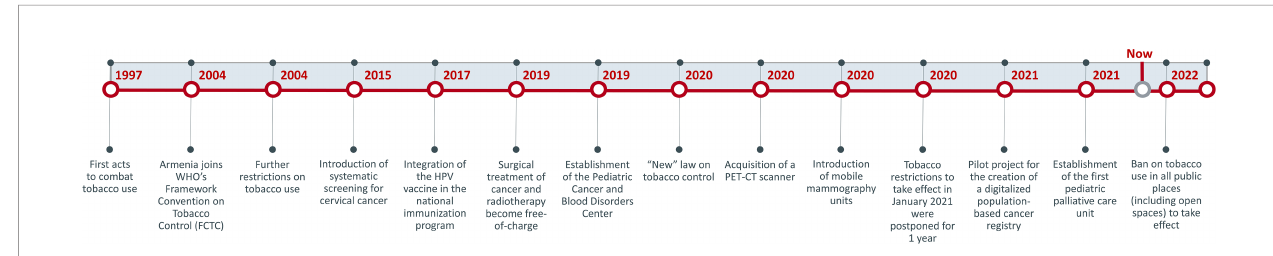
FIGURE 6 | Timeline of major events in the development of cancer care in